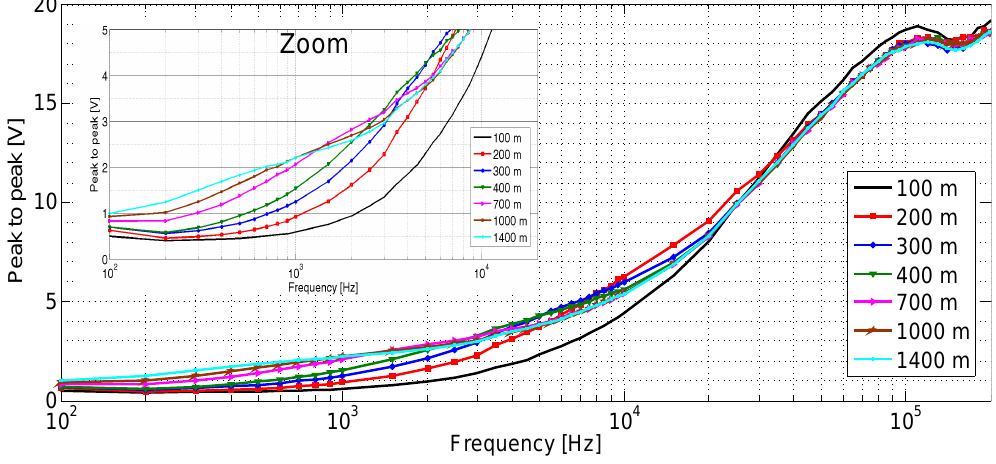
Figure 13. Observed sinusoidal peak to peak (PTP) value (Volts) with respect to the frequency (Hertz) for a track circuit in the MRS railway network for some short circuit positions. The frequency scan was from 100 Hz up to 200 kHz. The zoom was performed between frequencies from 0 to 6 kHz and amplitude from 0 to 5 PTP [V].